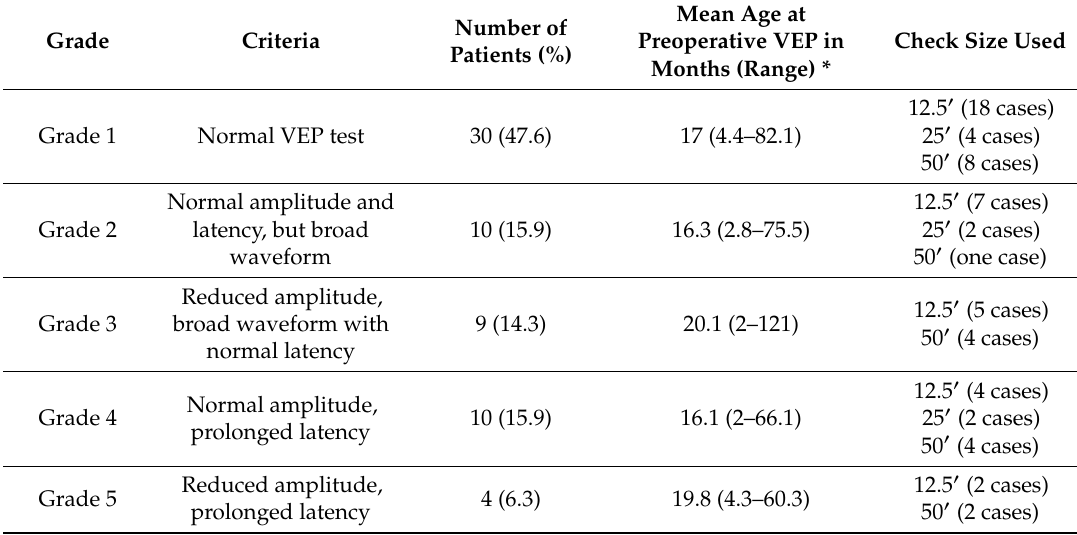
Table 1. The grading of patterned, visually-evoked potentials (pVEP) according to the Thompson and Nischal classification